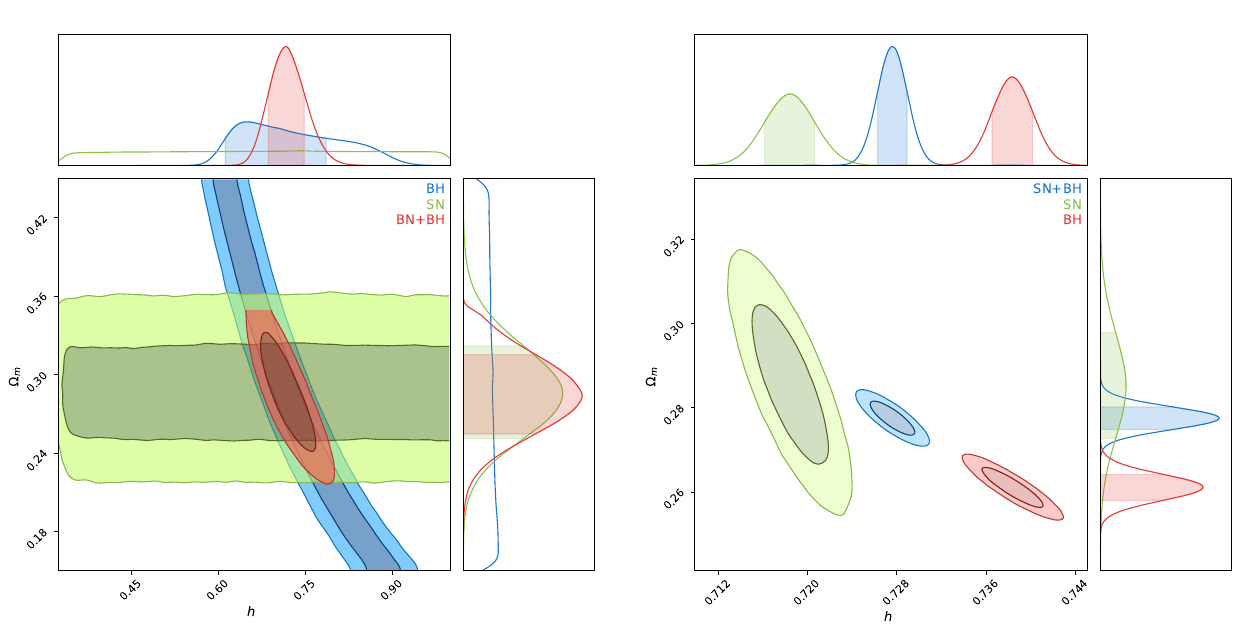
Figure 5. Left : Confidence contours C.L for the non-calibrated (full sample) Pantheon SNIa sample (here denoted by SN) and the high(er) redshift SMBH shadows simulations (here denoted by BH). Notice that SNIa (green color) gives a horizontal band that extends all over the range of values of h , which means that it can constrain the value for Ω m but is not able to constrain H 0 . The SMBH shadow simulations (blue color) form a region that extend widely along the values of Ω m . Our total statistics are given by the red C.L region, which allow usto constrain the cosmological parameters ( Ω m , H 0 ), see Table 2. Right : C.L for the calibrated (fixed M = − 19.3) Pantheon SNIa sample and the low redshift SMBH shadows simulations (here denoted by BH). Notice that SNIa (green color) gives a wider contour over the range of values of h and Ω m in comparison to the SMBH shadows simulations (red color) that form a smaller region and give higher values for h .